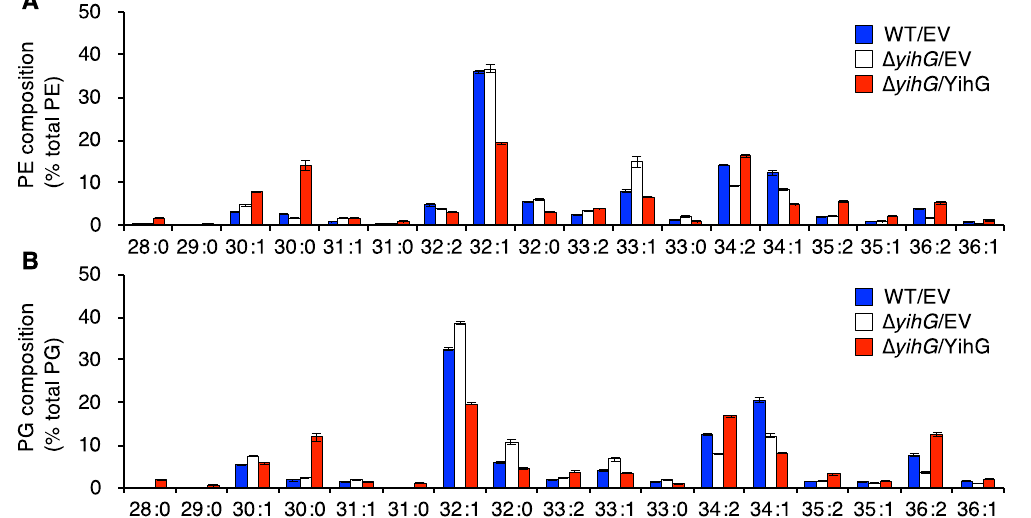
Figure 2. Effects of yihG disruption on PL composition. Total PLs extracted from cells grown at 37 °C to an OD 600 of 0.6–0.8 were analyzed by ESI–MS/MS. The graphs show the composition of PE ( A ) and PG ( B ) derived from wild-type cells harboring the pBAD-Cm R empty vector (WT/EV, blue) and ∆ yihG cells harboring the pBAD-Cm R empty vector ( ∆ yihG /EV, white) or pBAD/ yihG-his 6 ( ∆ yihG /YihG, red). Data are shown as the mean ± SD ( n =